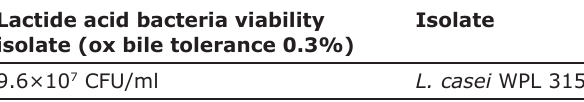
Table-4: LAB survival test on oxbile salts after 24 h, starting inoculums 2.90×10 8 Lactide acid bacteria viability isolate (ox bile tolerance